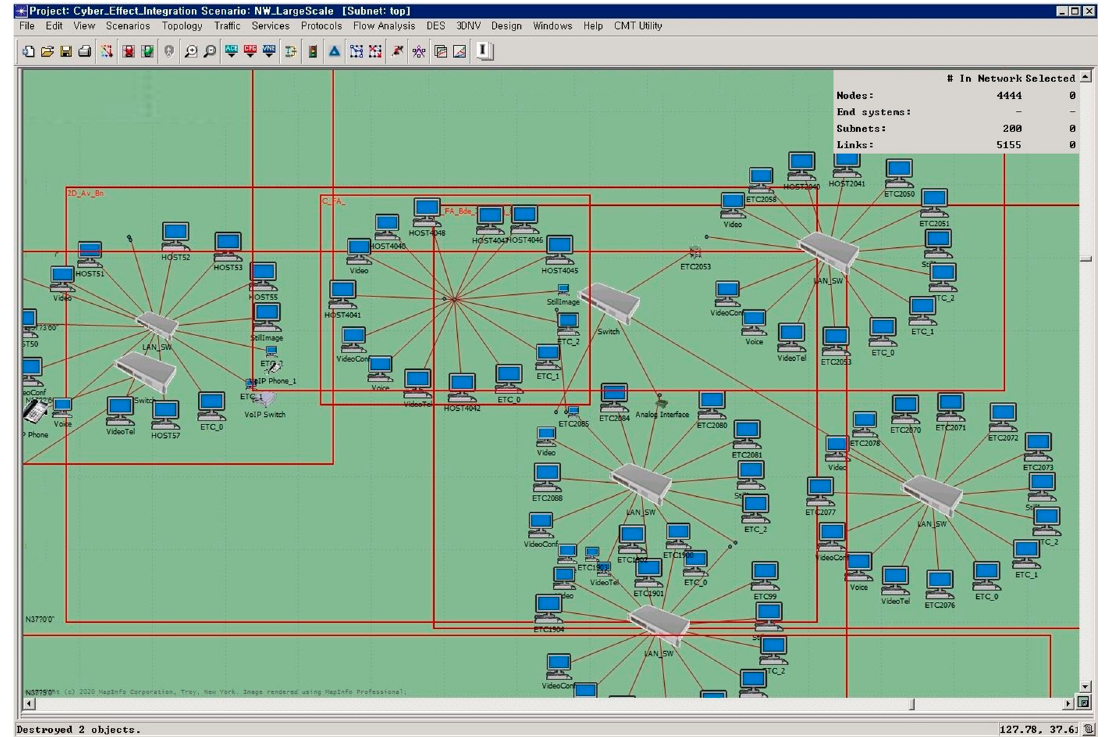
Figure 9. Part of a large-scale network with 4444 nodes and 200 subnets.